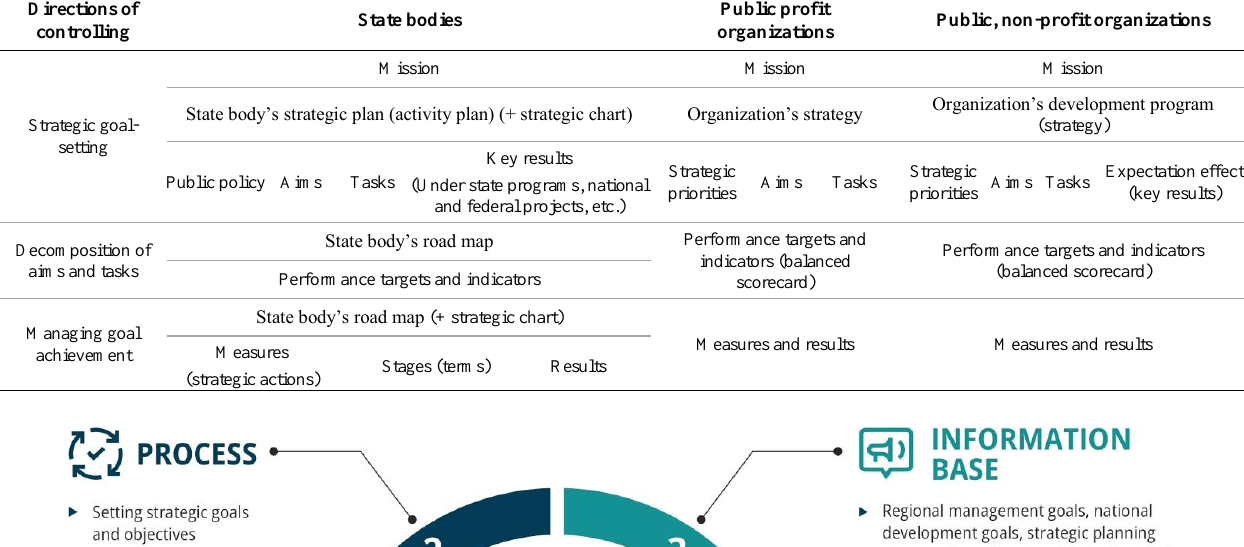
Table 2. Directions of controlling in the field of strategic planning of the state bodies and organizations’ activities Directions of controlling